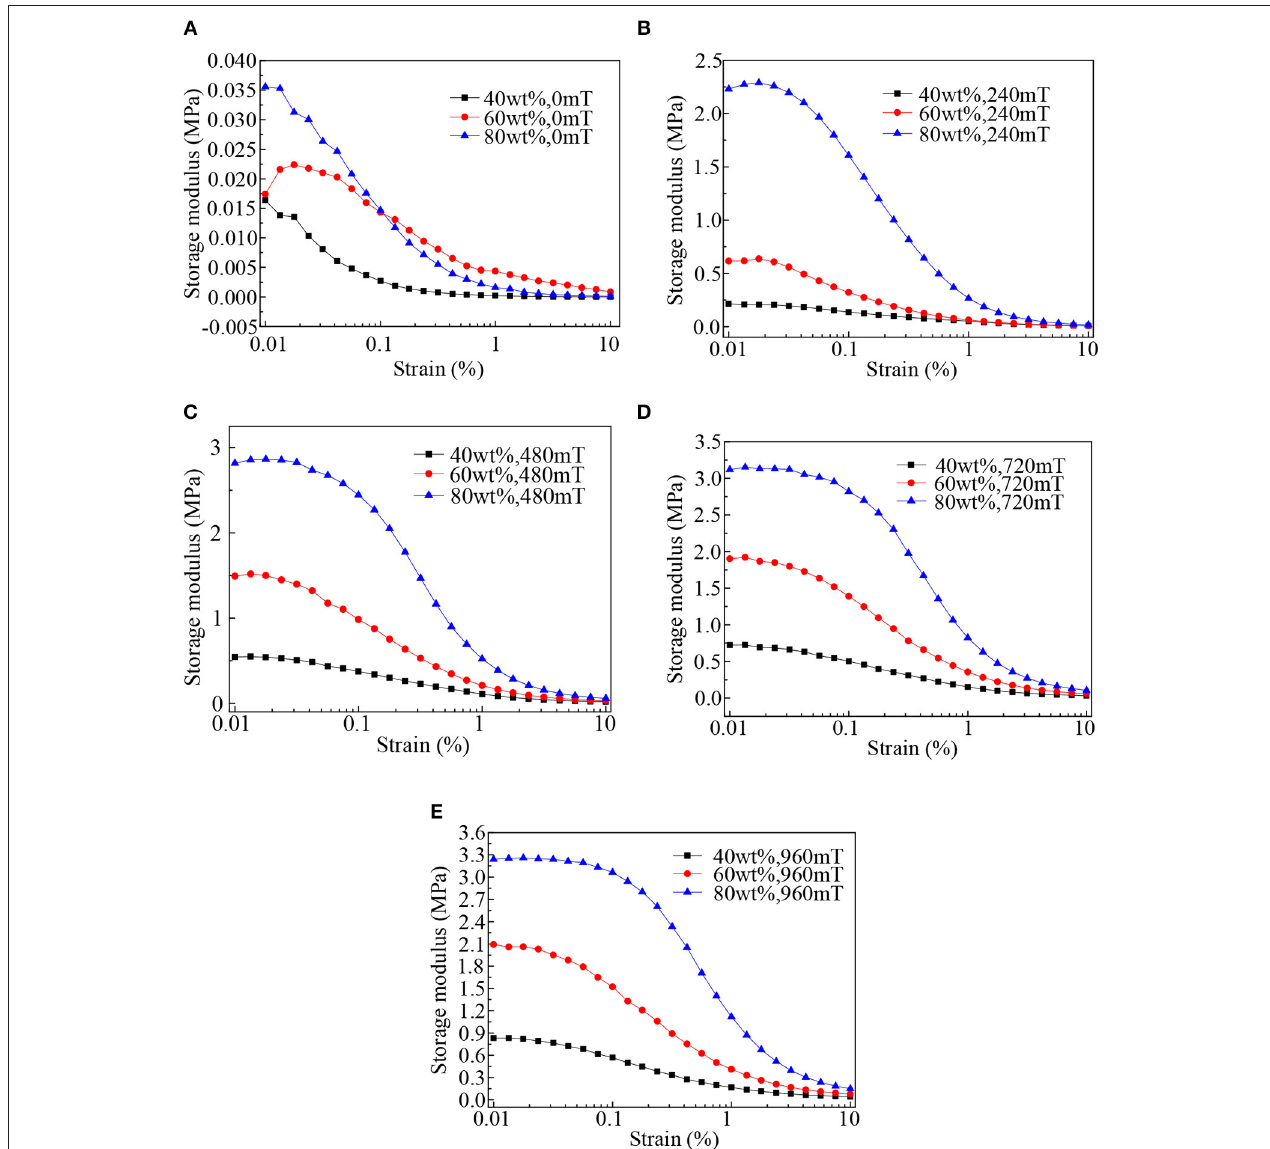
FIGURE 6 | Storage modulus of samples as a function of strain under different magnetic flux densities. ( A : B = 0mT; B : B = 240mT; C : B = 480mT; E : B = 720mT; E : B =